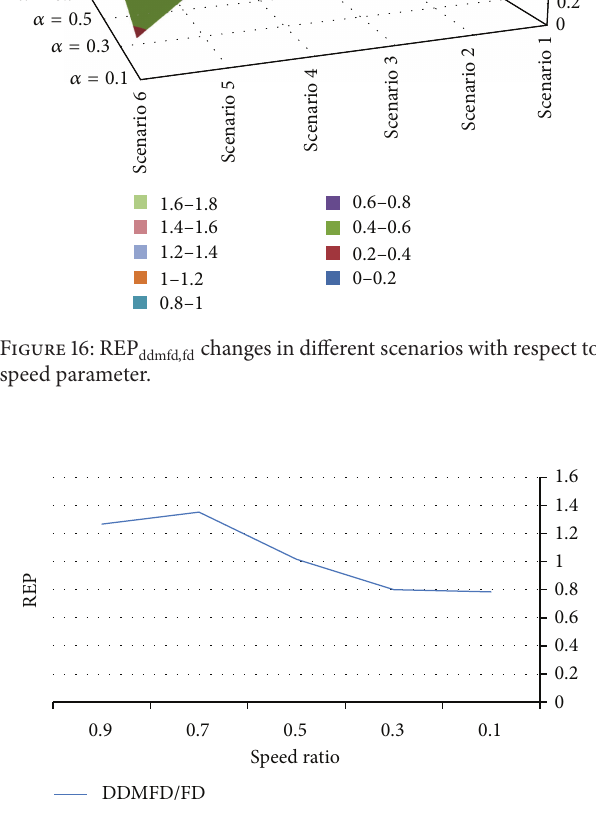
changes with respect to speed ddmfd , fd